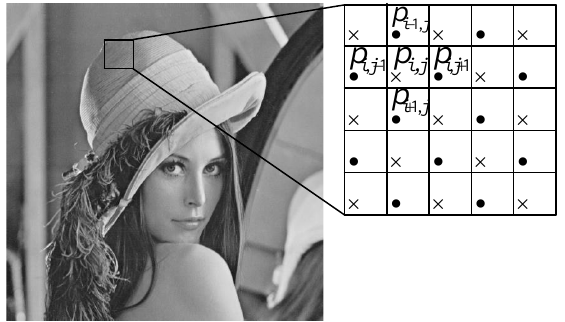
Figure 2. Pixel prediction procedure for a